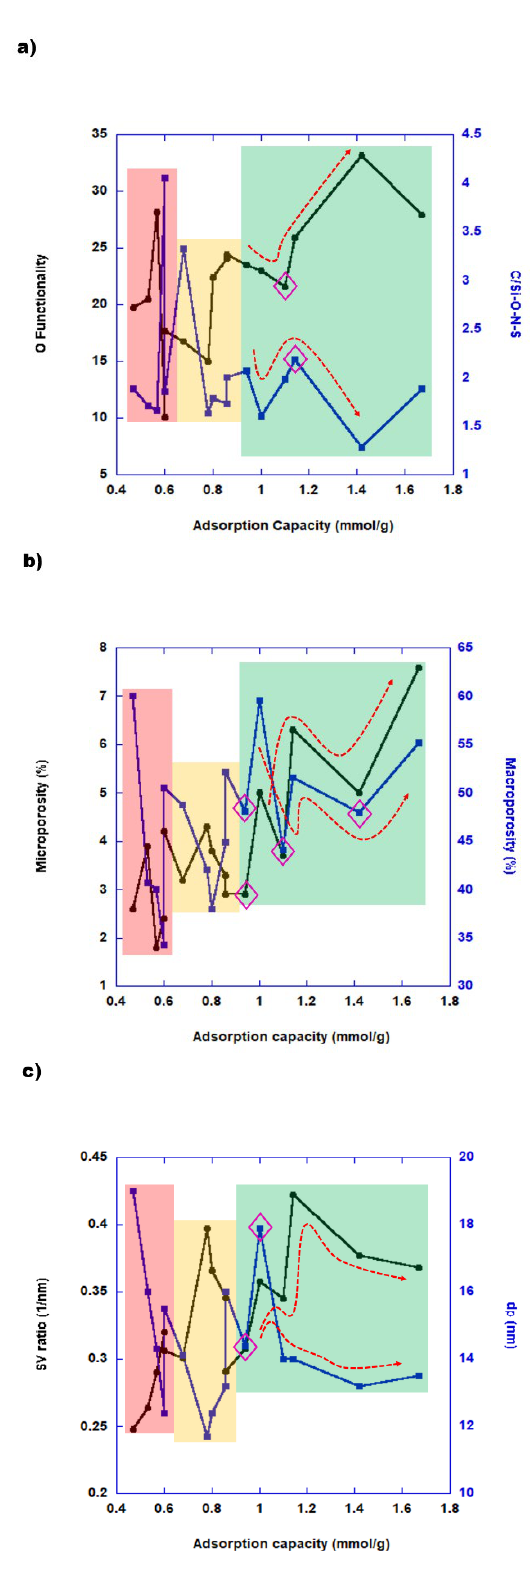
Figure 8. Comparison of CO 2 adsorption with: ( a ) oxygen functionality and ratio C/Heteroatoms; ( b ) percentages of micropores and macropores; ( c ) SV ratio and average pore diameter (dp). Hypothesizing samples with high O functionality (more than 23%), high microporosity percentage (more than 3.7%), and SV more than 0.345 showed the highest CO 2